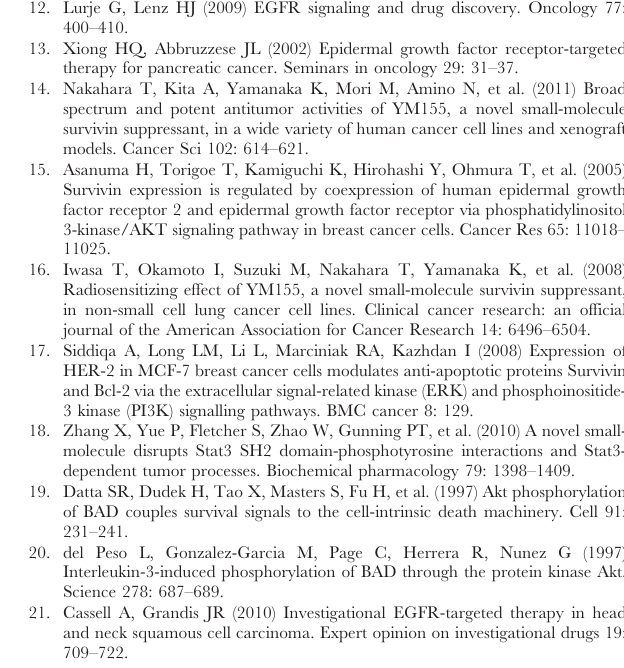
(TIF) Figure S7 Treatment of YM155 for 8 hours significantly reduces survivin levels. Effects of 100 nM YM155 on the expression of survivin, EGFR, and XIAP in PANC-1 cells according to time were determined by Western blotting. (TIF) Figure S8 YM155 induces the lysosomal degradation of EGFR, XIAP, and survivin in MIAPaCa-2 cells. MIAPaCa- 2 cells were treated with 100 nM YM155 (YM), 10 m M MG-132 (MG), 50 m M chloroquine (CQ), or 30 m M Z-VAD-fmk (Z-VAD) without or with YM155 for 24 hours. ctrl, control; M + Y, MG- 132 + YM155; C + Y, chloroquine + YM155; Z + Y, Z-VAD- fmk + YM155. (TIF) Materials and Methods S1 Cell lines, compounds, plasmid, and antibodies. Transfection and luciferase reporter assay. (DOC) Table S1 YM155 IC 50 values in gastric and colorectal cancer cell